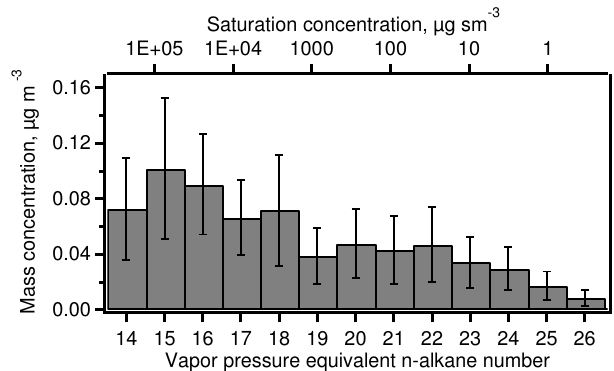
Figure 5. Average volatility distribution of total hydrocarbons ob- served by SV-TAG. The whiskers represent the standard deviation of the measurements. The volatility distribution was calculated us- ing fitting of high-resolution mass spectrometry data, and the vapor pressures are estimated from retention times of n